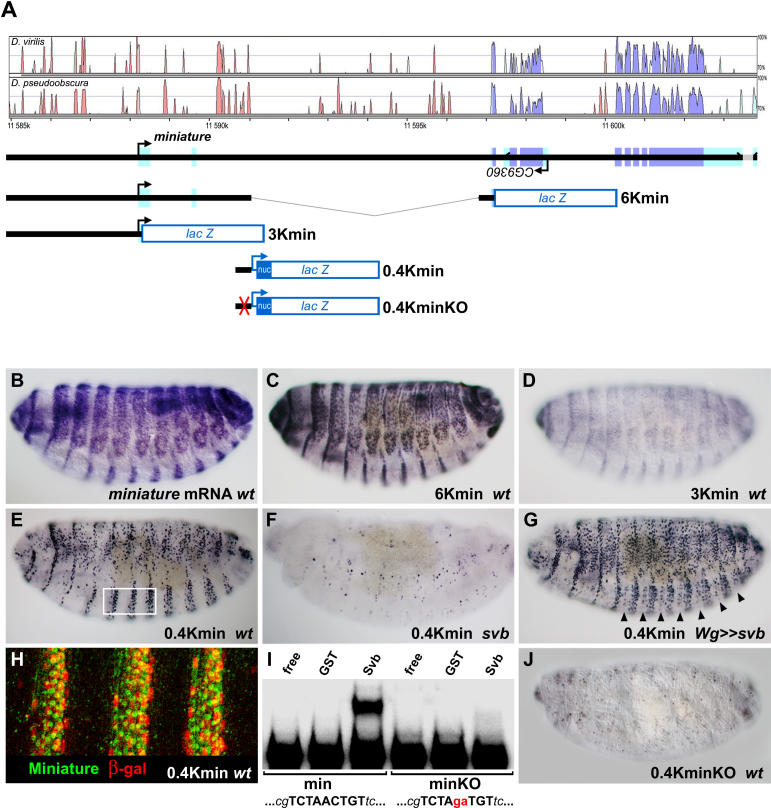
An Evolutionarily Conserved Enhancer Directs the svb-Dependent Expression of m
(A) Evolutionary conservation of the m locus and summary of transgenic reporter constructs. Transcribed regions of m span more than 15kb and harbor an unrelated gene, CG9360, transcribed from the complementary stand. Histograms plot the level of sequence conservation between D. melanogaster and D. pseudoobscura (top) or D. virilis (bottom), as represented from the Vista Genome Browser package. Red, light blue, and dark blue peaks correspond to conserved sequences in non-coding regions, 3′ and 5′ UTR, and translated sequences, respectively. Genomic regions displaying high evolutionary conservation were fused with reporter LacZ genes, encoding either a cytoplasmic (6Kmin and 3Kmin) or nuclear (0.4Kmin) β-gal enzyme, and used to generate transgenic lines.(B and C) Compared to m mRNA (B), 6Kmin constructs reproduce endogenous m expression (C).(D) Deletion of intronic sequences leads to a strong reduction of staining in 3Kmin constructs.(E) The 0.4Kmin construct drives m-like epidermal expression at a high level. The white box indicates the ventral region selected for the close-up presented in panel (H).(F and G) Like the endogenous gene, this enhancer is responsive to svb, since staining is absent in svb mutants (F) and additional stripes are produced after svb ectopic expression (arrowheads) (G).(H) Close up of the ventral region (segments A3–A5) of a 0.4Kmin embryo, showing that the β-gal reporter (red) is co-expressed with endogenous Miniature protein (green) in epidermal cells.(I and J) Electrophoresis mobility shift assays show the specific binding of the Svb protein to wild-type m enhancer. Introduction of 2 point mutations prevents in vitro binding (I) and leads to an inactive enhancer when assayed in vivo (J). Sequence of the Svb binding site (capital letters) and introduced mutations (red) are indicated.